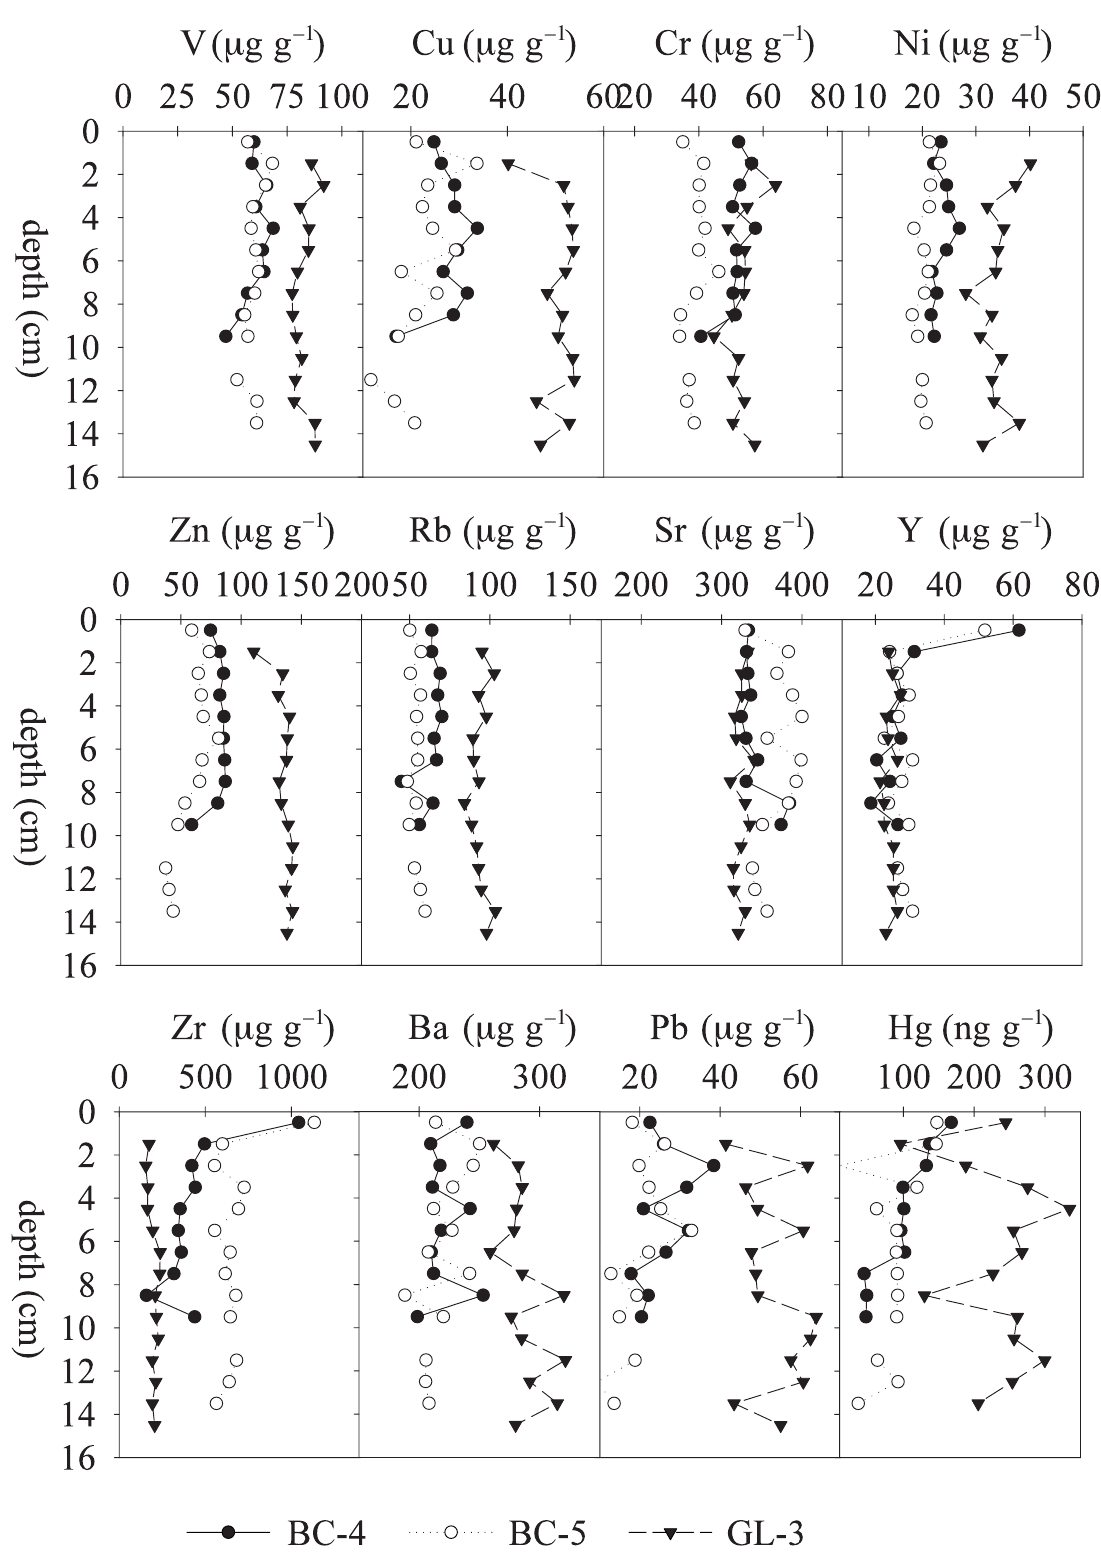
Fig . 4. – Depth profiles of trace elements in the sediment cores from the Gulf of Cádiz. The origin of the cores is shown in Figure 1. Sediment cores BC4 and BC5 were obtained from the outer Bay of Cádiz, whereas core GL3 was obtained from the submarine prodelta of the River